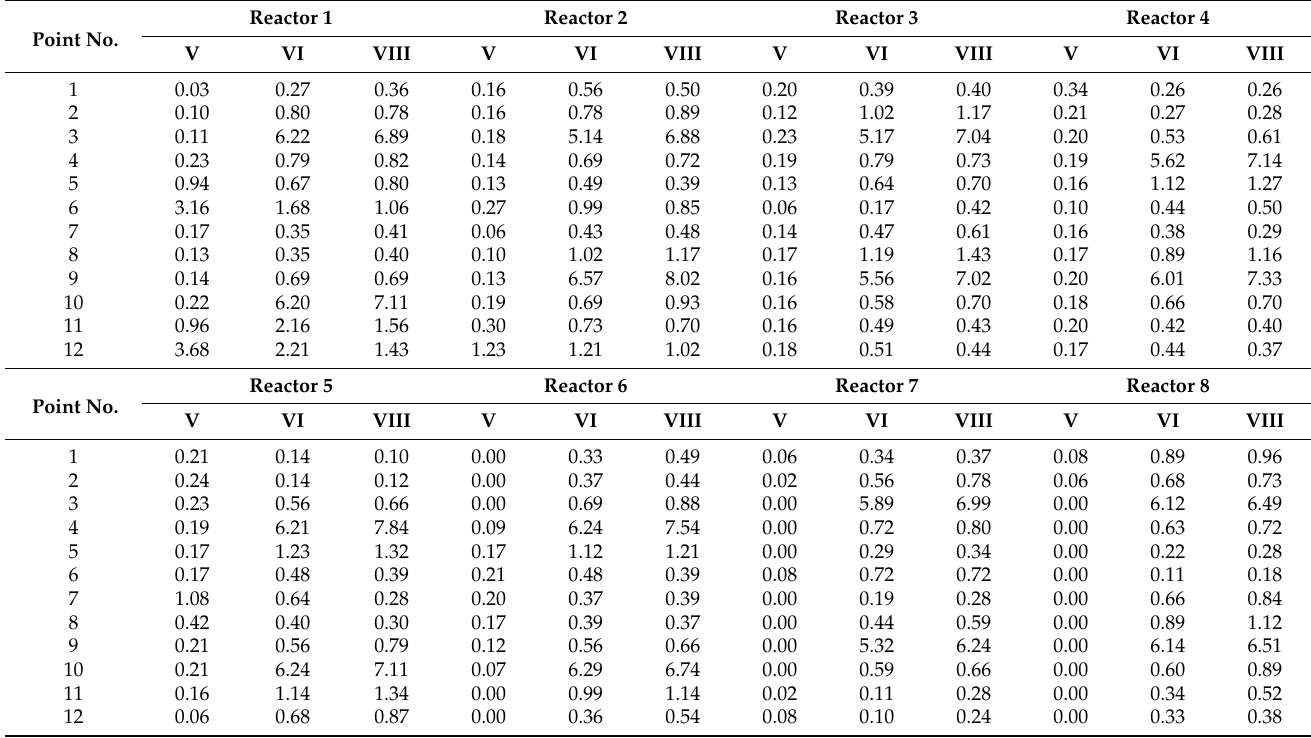
Table 3. Oxygen concentrations [mg/L] at measuring points 1.0 m above the bottom level. Roman numerals indicate months of